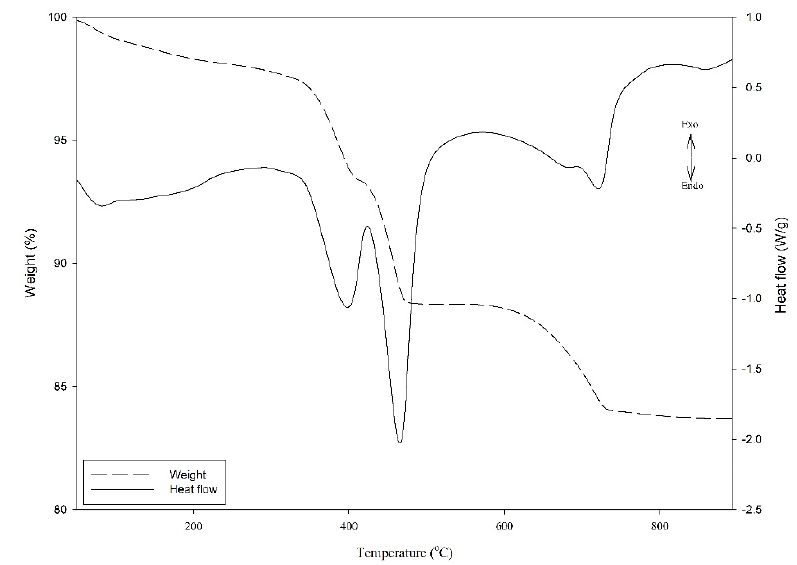
Figure 3. Illustration diagram of TGA result.